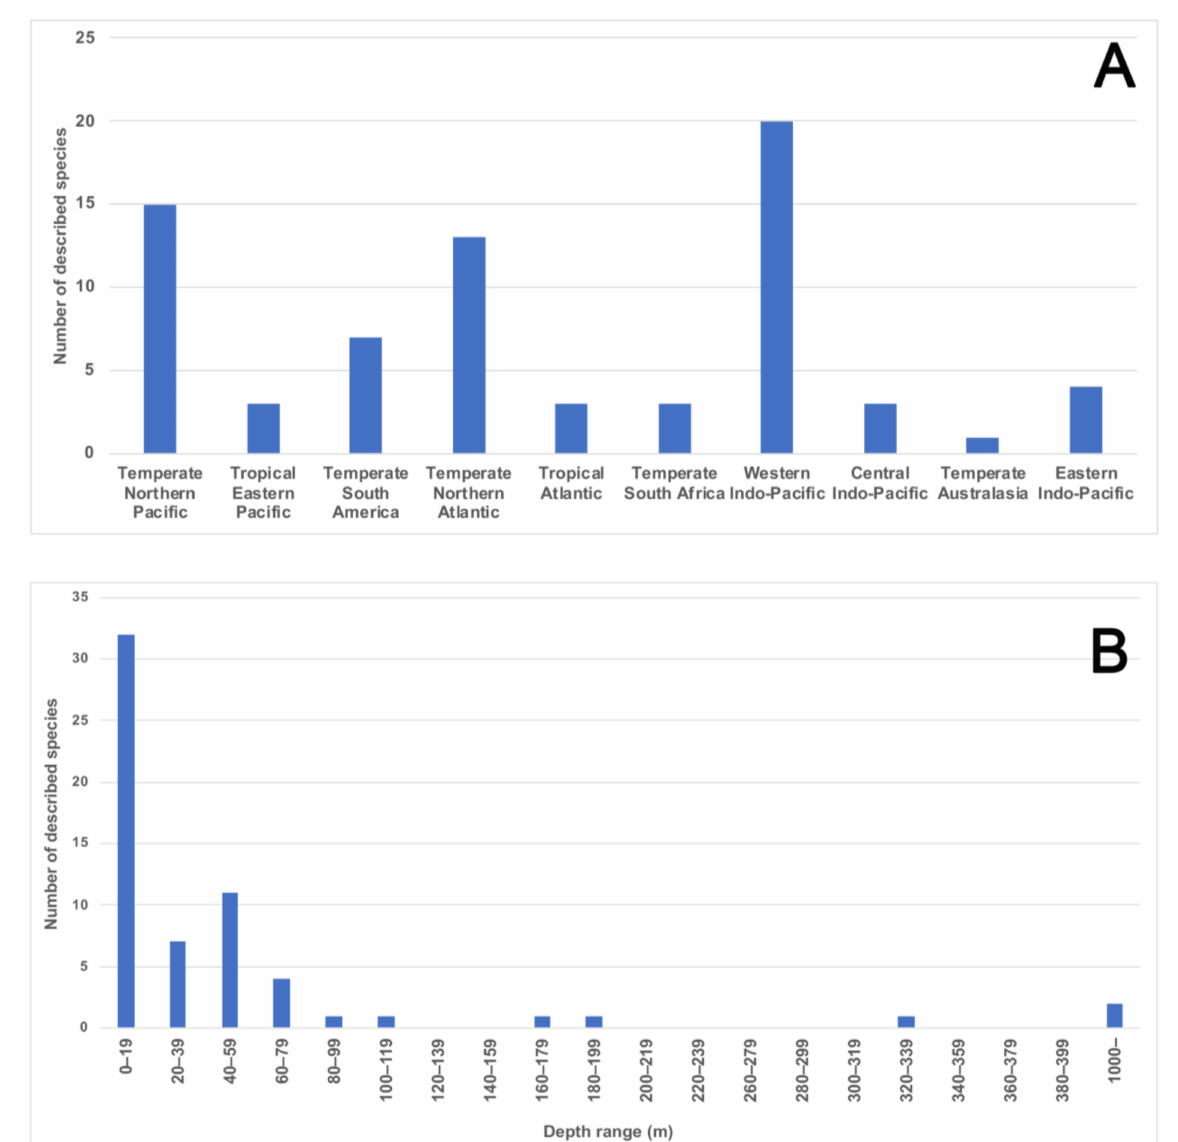
Figure 9. ( A ) All 72 magelonid species currently consider valid [58] listed under the marine realms (sensu [86]) from which they were described. Numbers indicate the number of species described from each bioregion; ( B ) number of species described from each depth range (depth in meters, data from the original descriptions of 61 species for which the data was